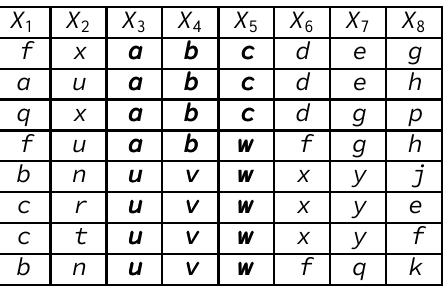
Table 1. Example Set of Temporal